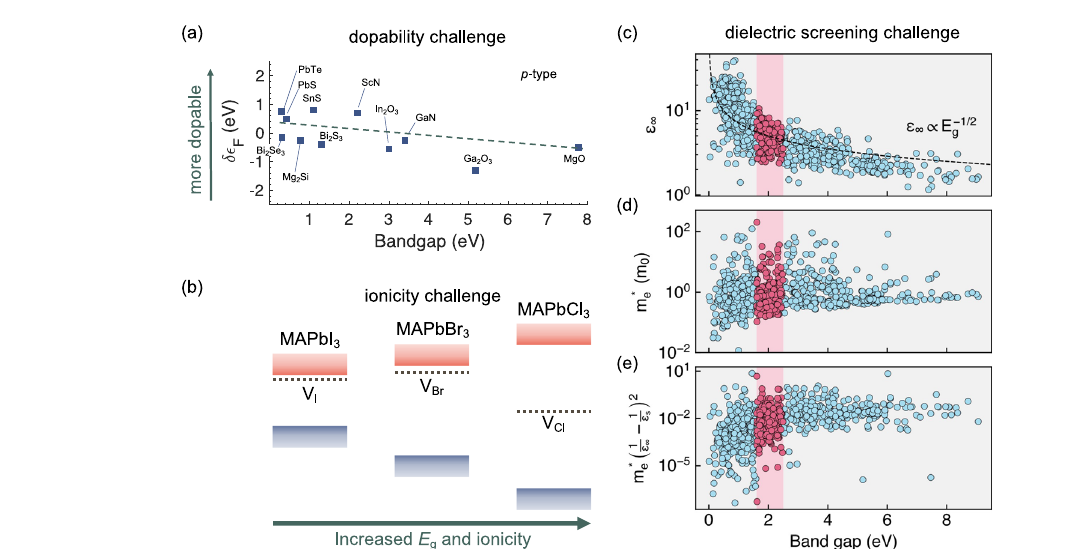
Fig. 1 | The defect challenge for wide-gap semiconductors. a Dopability chal- lenge.Plot of the ability to dopematerials ( δε F )asa function of theirbandgap ( E g ). fi nedasthedifferencebetweentheband-edge(valencebandmaximumfor δε F isde p-type doping) and doping pinning energy. δε F from defect calculations in ref. 10, while the bandgaps shown are experimentally measured values. Trend line added to guide the eye. b Ionicity challenge. Energy of the (0/+) transition level of the halide vacancy for CH 3 NH 3 PbX 3 perovskites. Dielectric screening challenge. c Plot of electronicdielectricconstant( ε ∞ ), d electroneffectivemass( m e ), and e Fröhlich